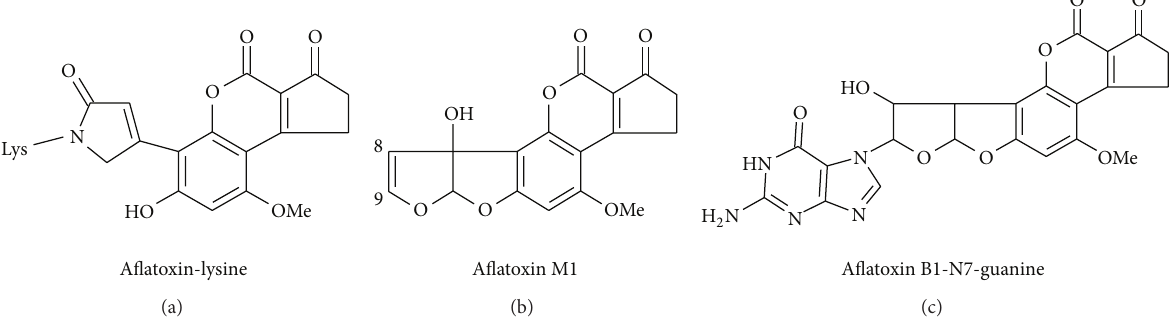
Figure 3: Structures of the aflatoxin species measured is validated exposure biomarkers. Aflatoxin-lysine is the digest product of aflatoxin- albumin detected in sera, AFM1 is the hydroxy metabolite detected in urine, and aflatoxin-N7-guanine is the depurination product of aflatoxin-DNA